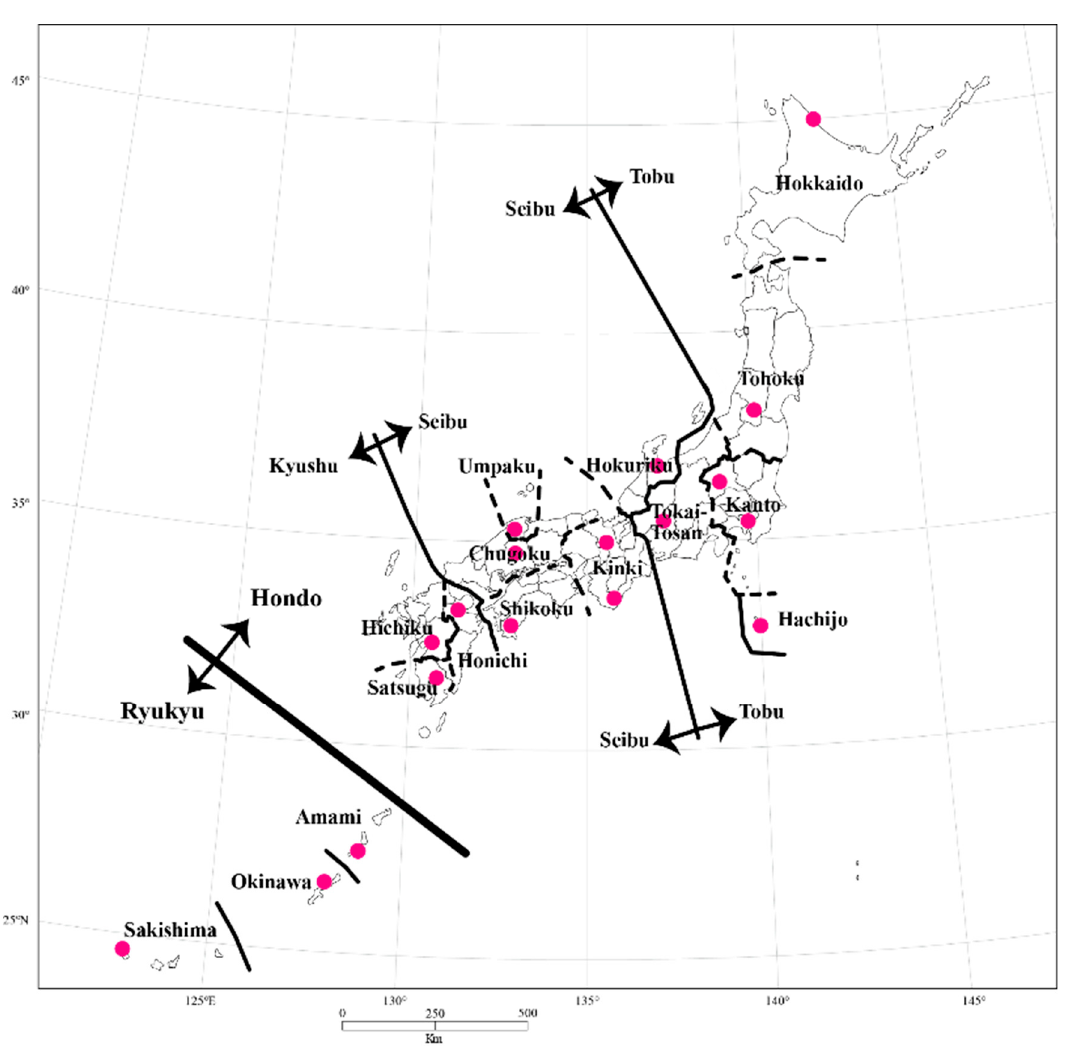
Figure 2. Reference places of the Linguistic Atlas of Japan (LAJ) and Grammar Atlas of Japanese Dialects (GAJ) data.